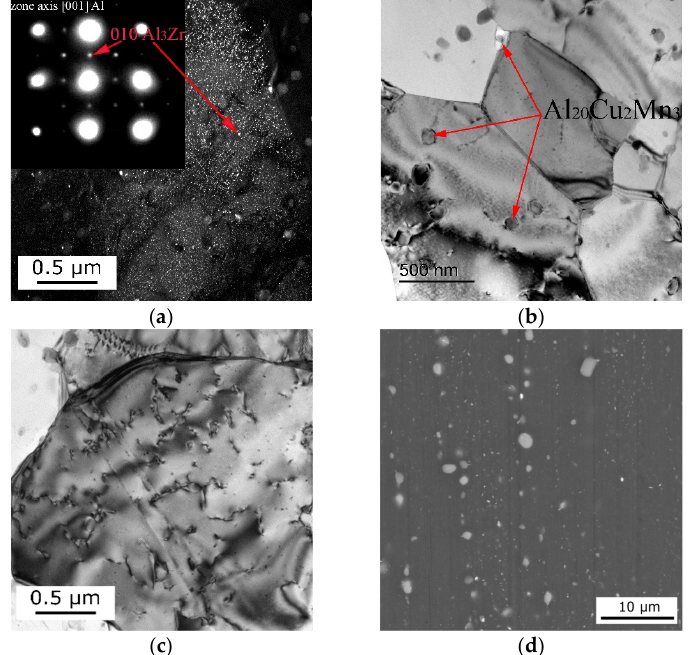
Figure 2. Electrical conductivity ( a,b ) and hardness ( c,d ) and vs. temperature curves for experimental alloys: ( a,c ) ingots and ( b,d ) cold rolled sheets. A measurement error for SEC values: ±0.22 MS/m for as-cast samples and ±0.08 MS/m for rolled samples. A measurement error for hardness values: ±2 HV for as-cast and rolled samples.